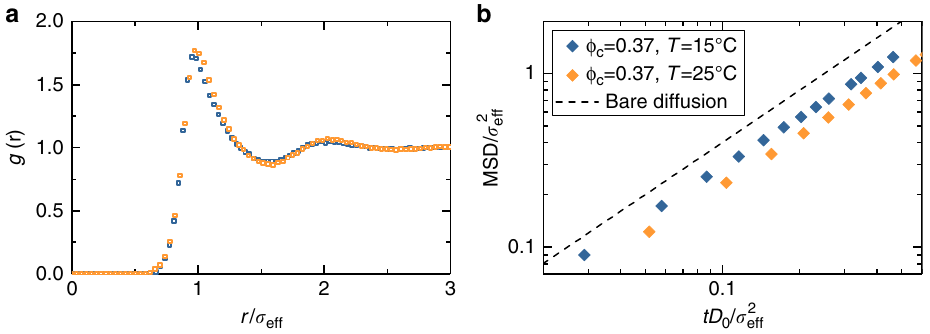
Fig. 2 Structure and dynamics for two state points at different temperature with equivalent packing fraction. ( a ) Experimental g ð r Þ and ( b ) MSD for samples with ϕ eff,c = 0.37 at two different temperatures ( T = 15 and 25 °C) corrected for size. D 0 is the zero-colloid limit diffusion coef fi cient and its associated MSD (dashed line) is also